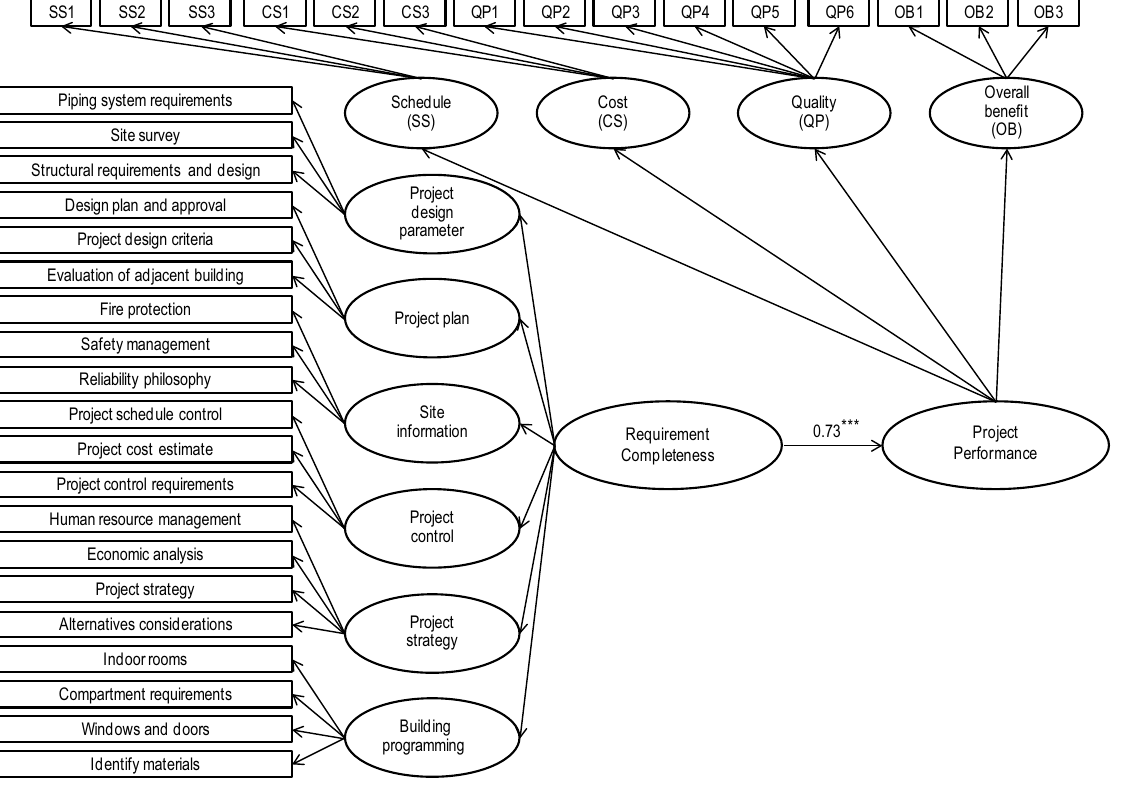
Fig. 4. Research model estimation